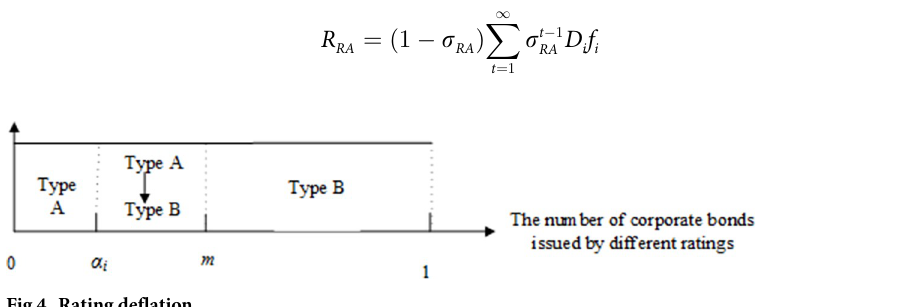
Fig 4. Rating deflation.